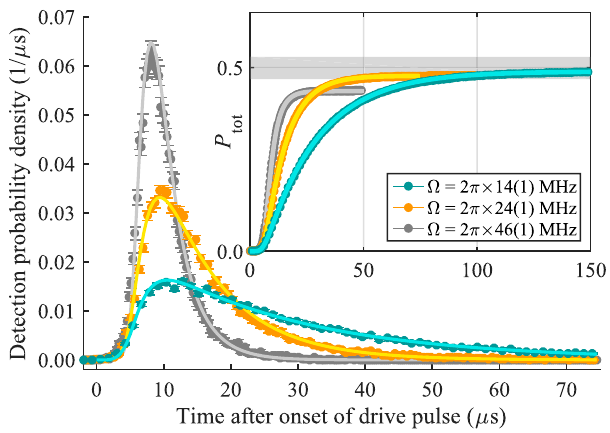
FIG. 3. Single-photon wavepackets and efficiency. Histograms of photon arrival times for different Rabi frequencies (cid:8)/ 2 π = [14 ( 1 ) , 24 ( 1 ) , 46 ( 1 ) ] MHz of the drive laser, normalized by the number of attempts k = 50 000 and by the time-bin width δ t = ( 1.2, 0.6, 0.3 ) μ s. Inset: integrated wavepackets, yielding effi- ciencies (averaged over a measurement time of about 8 min) P tot = [0.490 ( 3 ) , 0.478 ( 3 ) , 0.437 ( 3 ) ]. All plots: dots are exper- imental data, lines correspond to numerical simulations. Error bars correspond to one standard deviation based on Poisso- nian photon-counting statistics. Gray shaded area: P exp.max P path , i.e., maximum achievable total efficiency from the ana- lytic model [calculated via Eq. (1)] given our detection-path